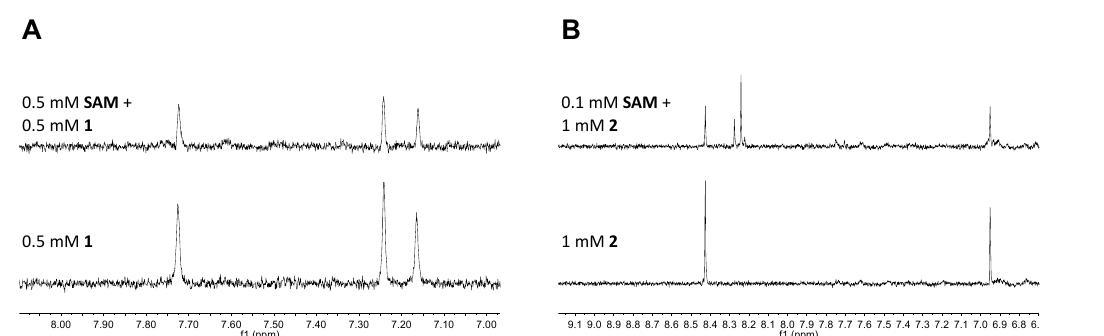
Figure 4. Chemical structures of ligands shown to bind at the cofactor site of hFBL.